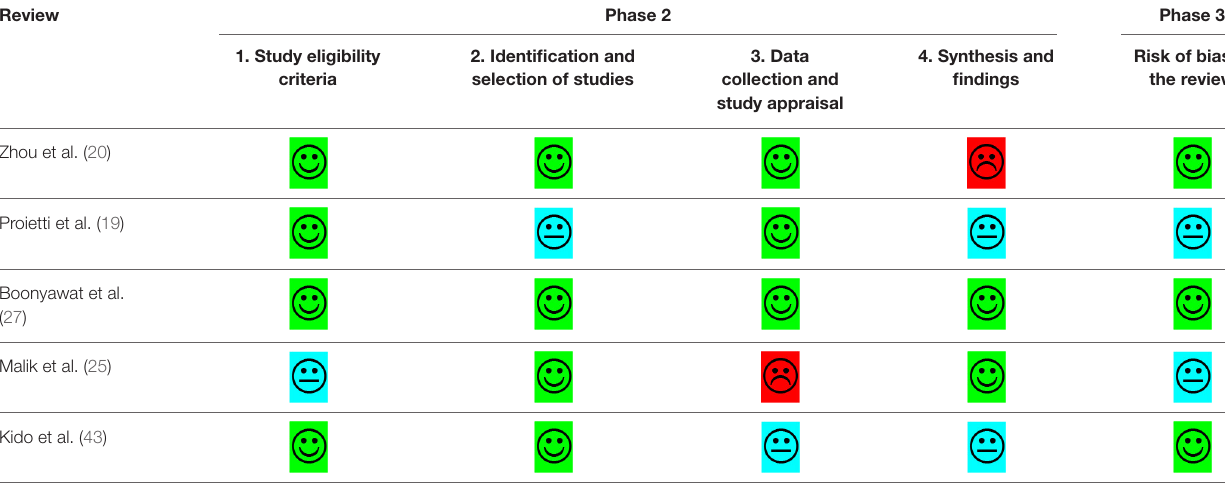
TABLE 2 | Risk of bias using ROBIS